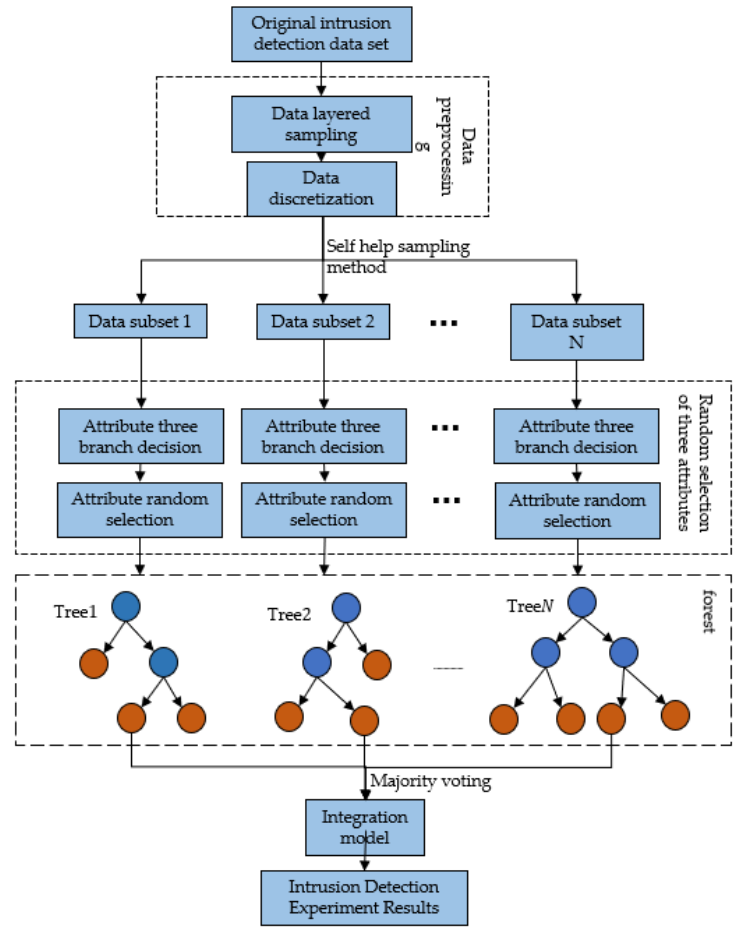
Figure 5. IDTSRF